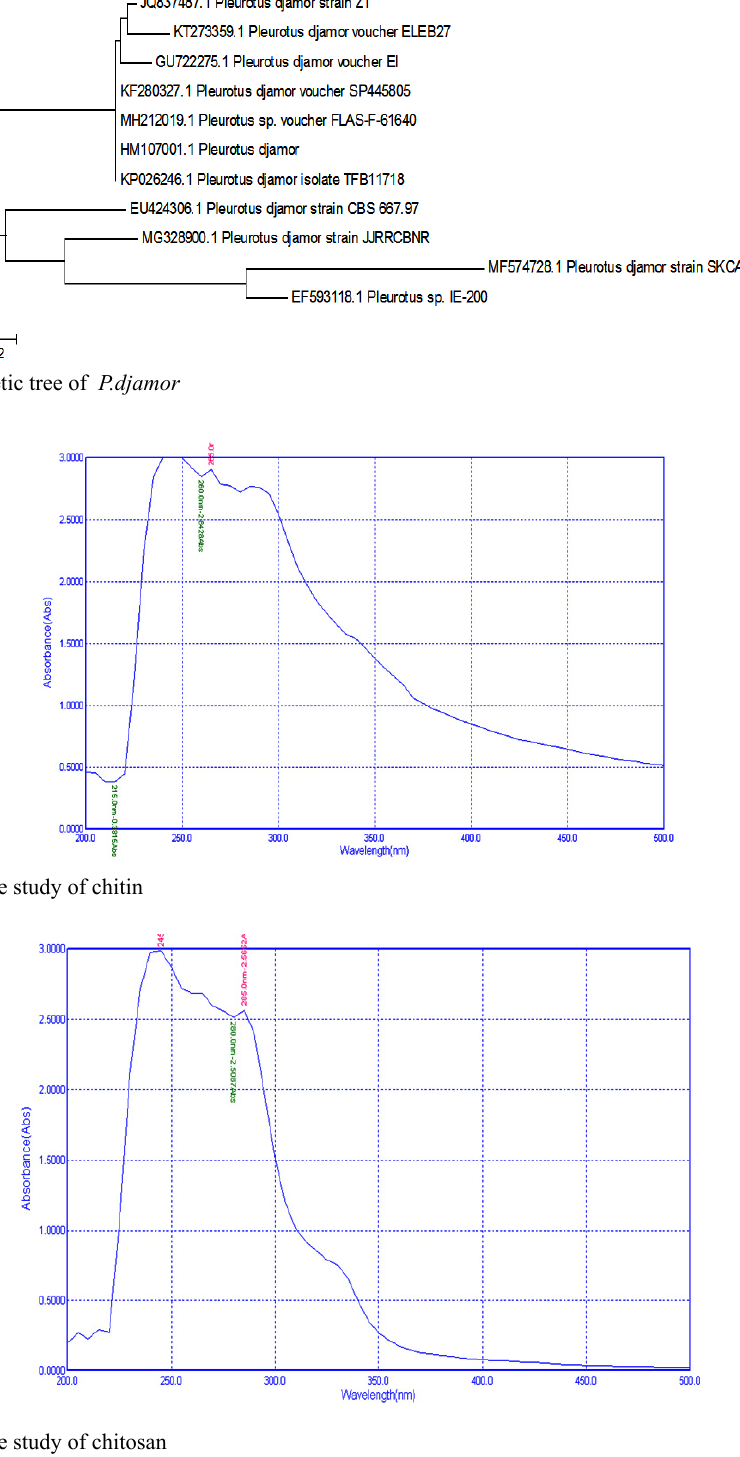
Fig. 6. UV-Visible study of